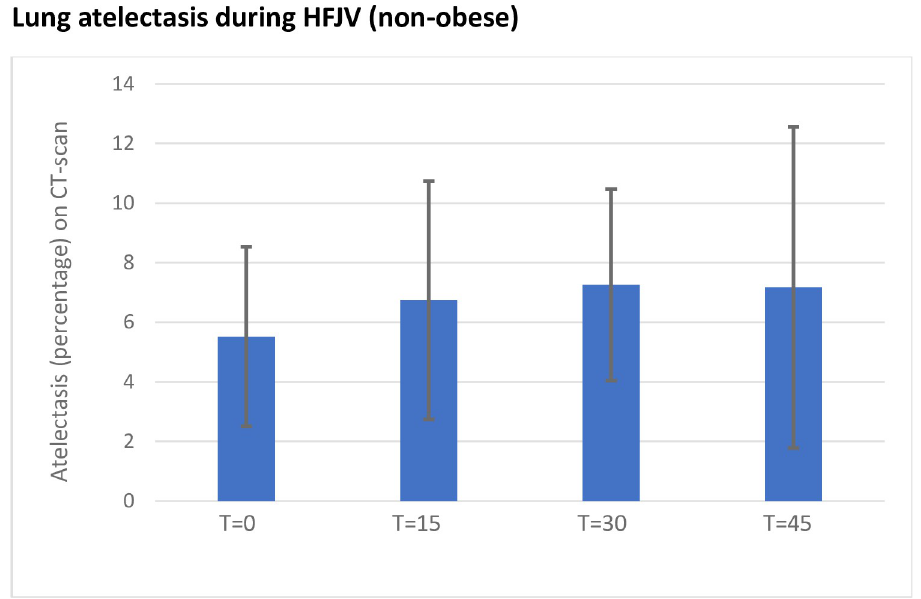
Fig 4. Mean atelectasis in percentage (HU -100-+100) at the four timepoints for the 15 patients with a body mass index < 30. T = 0 being the first CT-scan after initiation of HFJV (high frequency jet ventilation) and thereafter CT- scans every 15 minutes. For this subgroup no statistical difference could be seen between the timepoints even though an initial visual trend is noted.